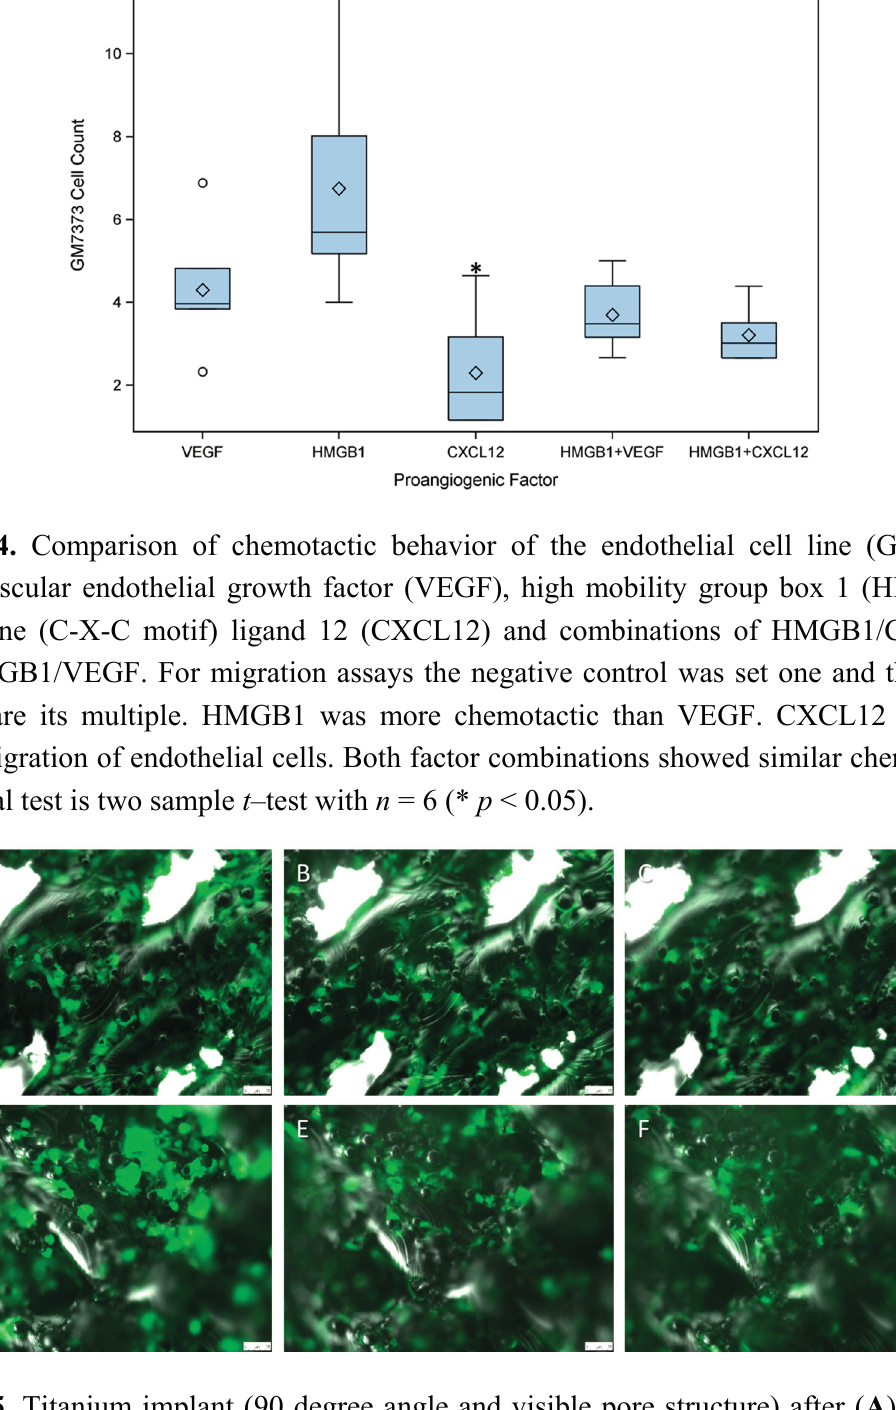
Figure 5. Titanium implant (90 degree angle and visible pore structure) after ( A ) 0 days; ( B ) three days; and ( C ) seven days and titanium PCL implant (45 degree angle and invisible pore structure) after ( D ) 0 days; ( E ) three days; and ( F ) seven days of GFP–osteoblast settling. (Scale bar: 75